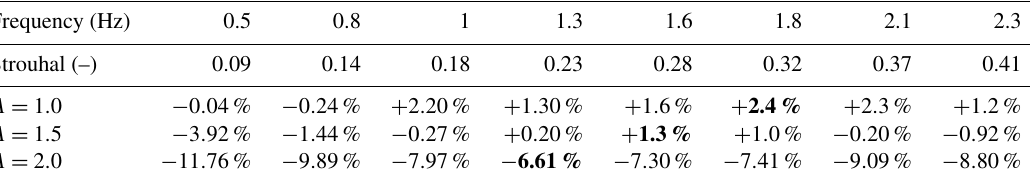
Table 4. An overview of the total power increase with respect to the baseline case by applying dynamic induction control with different amplitudes ( A , rows) and frequencies (columns) for the low-TI case. In bold are the experiments that lead to the highest power capture for each amplitude, showing an optimum around St = 0 . 28.